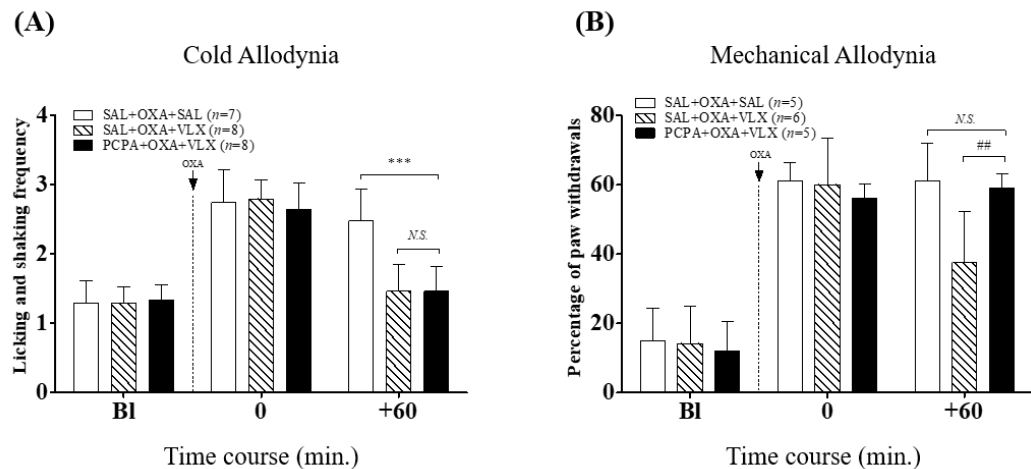
Figure 4. Roles of serotonergic pathway on the relieving effects of VLX on oxaliplatin-induced cold ( A ) and mechanical ( B ) allodynia in mice. PCPA (150 mg/kg/day, i.p.) or saline (SAL, vehicle) was administered before the oxaliplatin (OXA, 6 mg/kg, i.p., dotted line) treatment. On day four, mice underwent the measurements twice; just prior to the VLX (VLX, 40mg/kg, i.p.) or saline (SAL, vehicle) injection, and 60 min after the treatments. “Bl”, baseline; *** p < 0.001, vs. SAL + OXA + SAL; ## p < 0.01, vs. SAL + OXA + VLX; N.S. , no significance ( p > 0.05). Data was expressed as mean ± S.D. and analyzed with two-way ANOVA followed by Bonferroni’s post-test.